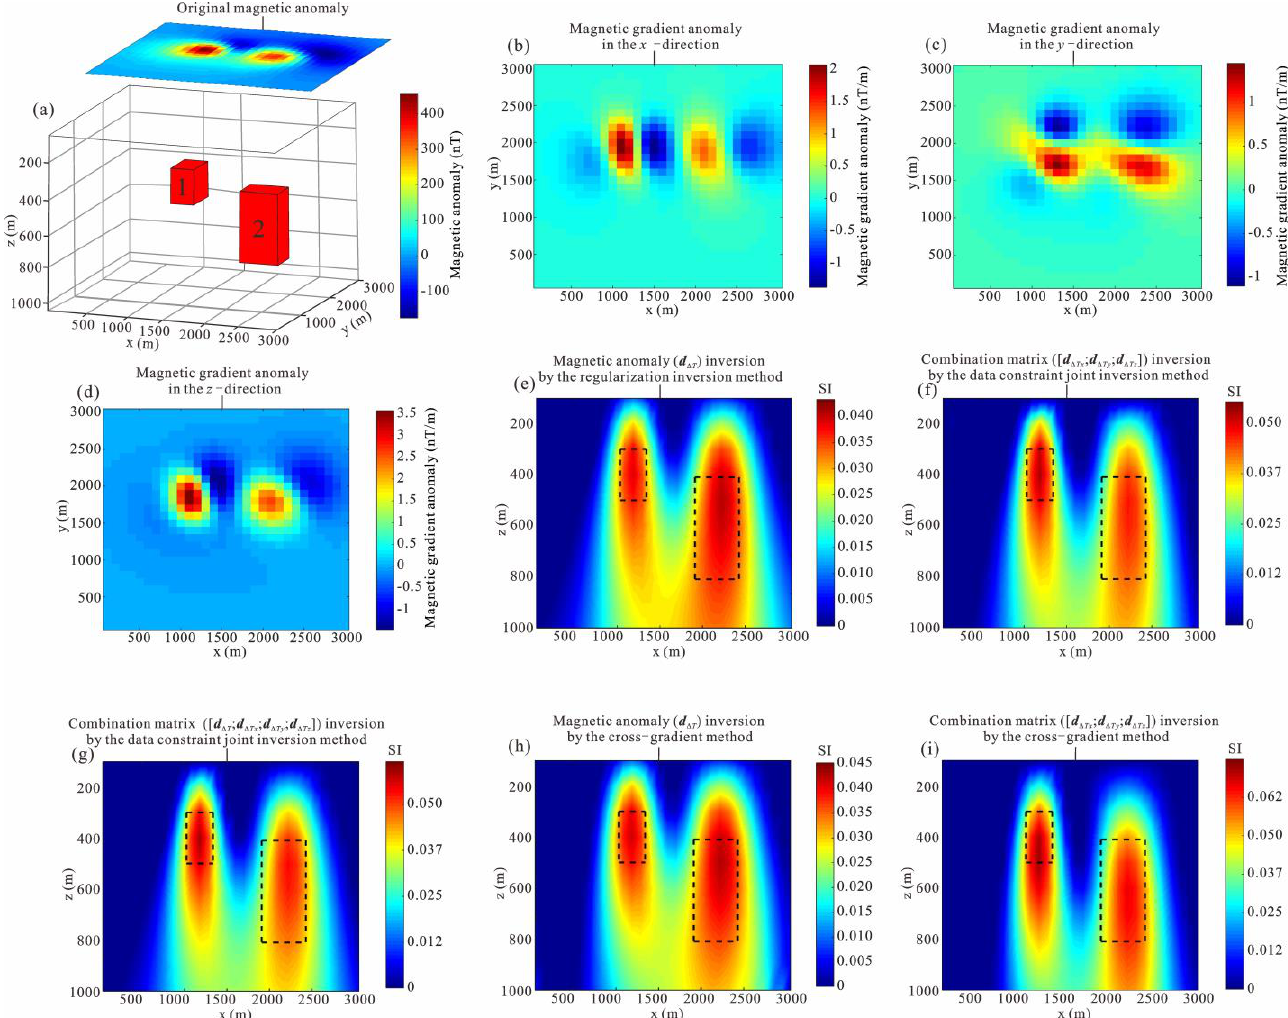
Figure 3. Magnetic and gradient anomalies and magnetic susceptibility slices ( y = 1900 m) obtained by different inversion methods. ( a ) 3D view of 2 prisms and magnetic anomaly. ( b ) Magnetic gradient anomaly in the x -direction. ( c ) Magnetic gradient anomaly in the y -direction. ( d ) Magnetic gradient anomaly in the z -direction. ( e ) Magnetic susceptibility slice ( y = 1900 m) obtained by regularization inversion of the magnetic anomaly ( d ∆ T ). ( f ) Magnetic susceptibility slice ( y = 1900 m) by data constraint joint inversion of the combination matrix ( ( h ) Magnetic susceptibility slice ( y = 1900 m) by cross-gradient inversion of the magnetic anomaly ( d ∆ T ). ( i ) Magnetic susceptibility slice ( y = 1900 m) by cross-gradient inversion of the